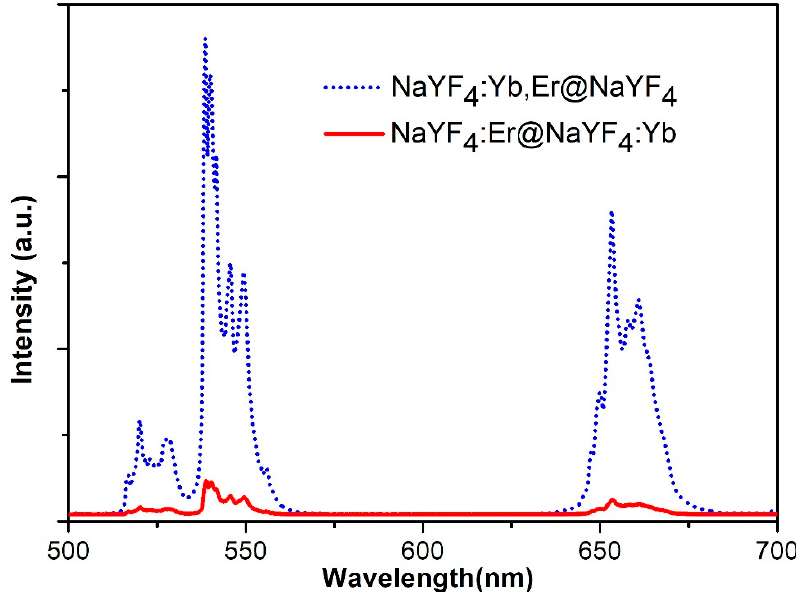
Figure 8. The UC emission spectrum of NaYF 4 :20%Yb 3+ ,2%Er 3+ @NaYF 4 :Yb 3+ and NaYF 4 :2%Er 3+ @NaYF 4 :20%Yb 3+ nanocrystals.